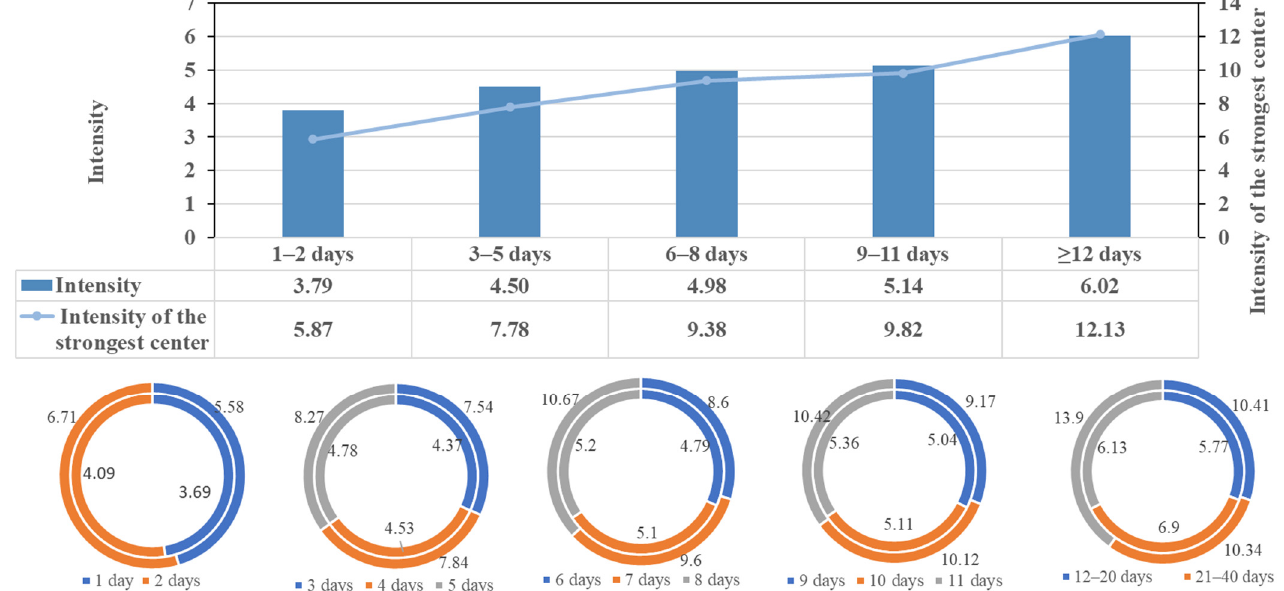
Figure 7. The intensity of heatwave events and the strongest center of intensity of different durations across China from 1979 to 2018. The pie charts beneath represent the percentage of the number of events of an individual duration to the total number of events in that stage of all durations. The outer and inner rings indicate the strongest center of intensity and event intensity, respectively, and the nearby numbers represent the average intensity value of the events for an individual duration.